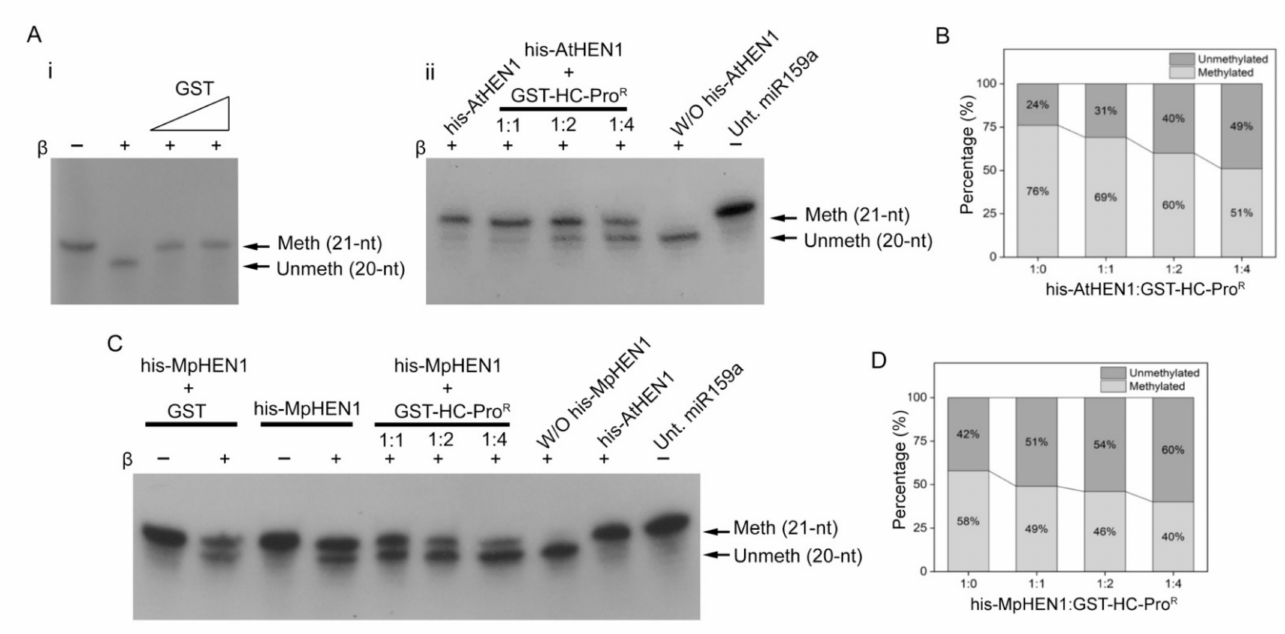
Figure 6. The in vitro HEN1 activity inhibition assay. ( A ) The in vitro HC-Pro R -mediated his-AtHEN1 inhibition assay. The GST was used as a negative control (i). The different ratios of his-AtHEN1 vs. GST-HC-Pro R were performed in the HEN1 inhibition assay (ii). ( B ) Graph depicting quantification of GST-HC-Pro R -mediated his-AtHEN1 inhibition. ( C ) The in vitro HC-Pro R -mediated his-MpHEN1 inhibition assay. The different ratios for his-MpHEN1 vs. GST-HC-Pro R were performed in the HEN1 inhibition assay. ( D ) Graph depicting quantification of GST-HC-Pro R -mediated his-MpHEN1 inhibition. Meth, the 21-nt position of methylated miRNA. UnMeth, the 20-nt position of unmethylated miRNA. Untreated miR159a is abbreviated as Unt.